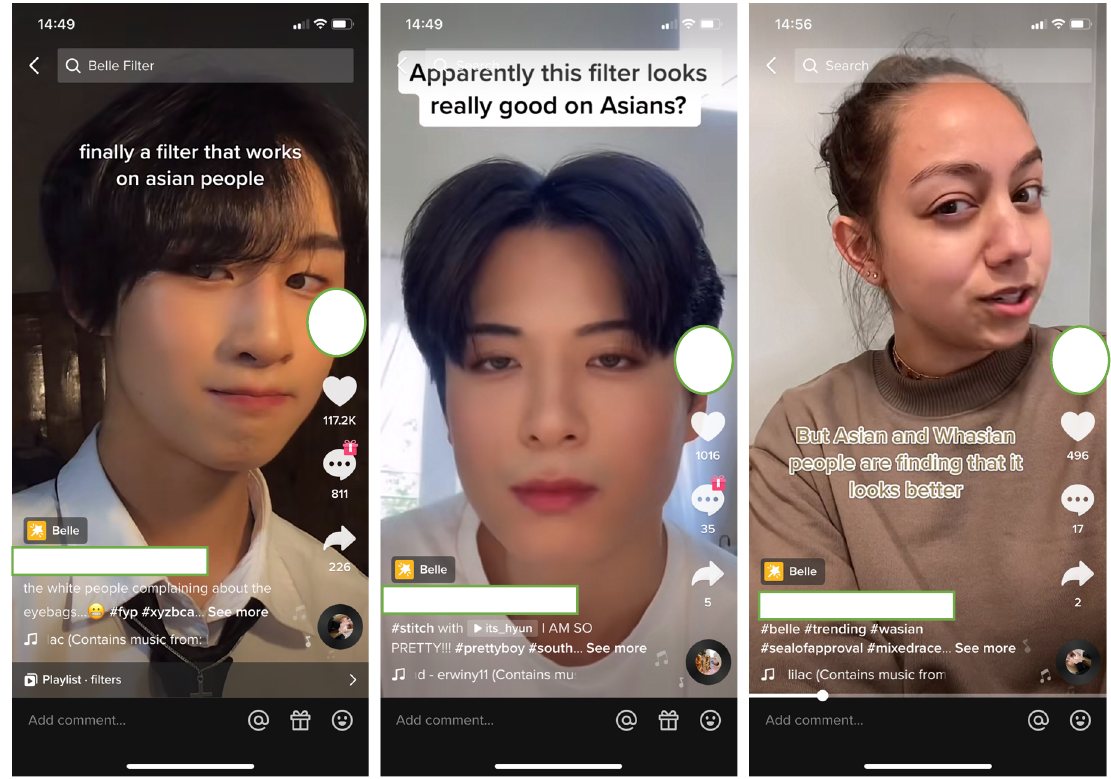
Figure 10. Examples of responses to the ‘Belle’ filter.